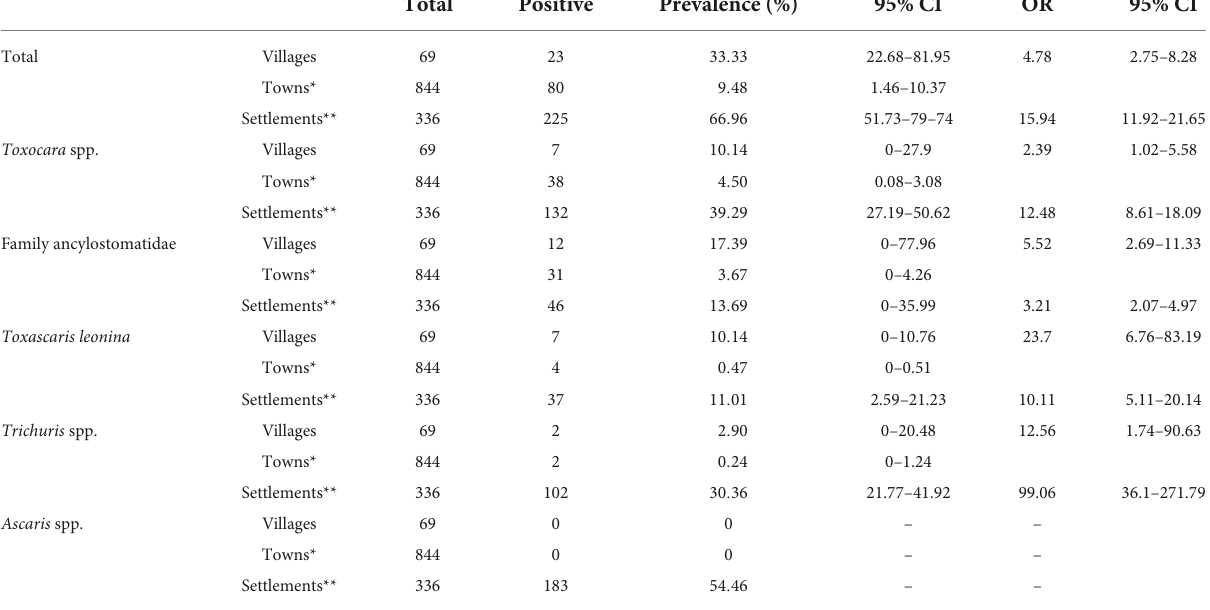
TABLE 4 Soil-transmitted helminths (STH) eggs prevalence in the soil is categorized by the environment. Total Positive Prevalence (%) 95%